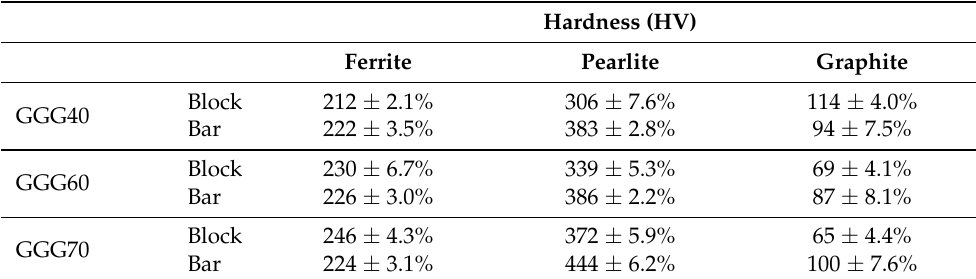
Table 3. Microindentation test